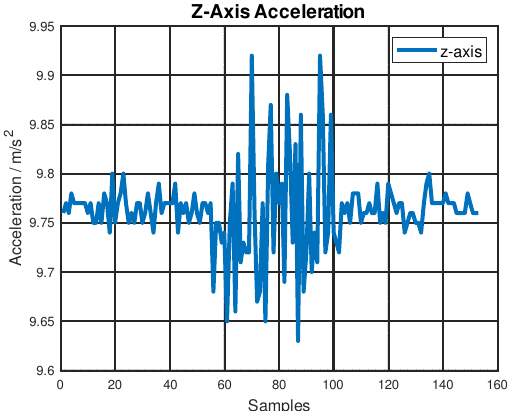
Figure 7. BNO055 acceleration measurements on the z -axis during dynamic testing.